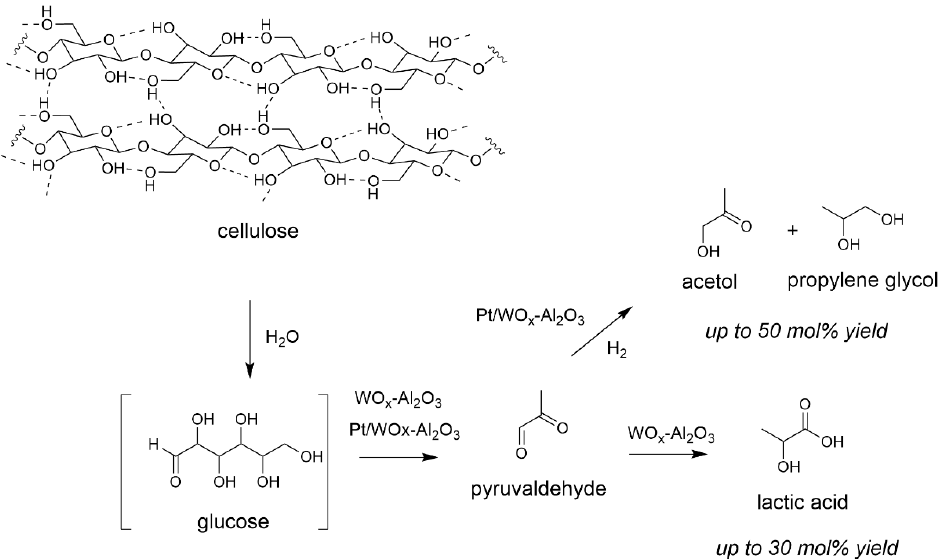
Scheme 3. Reaction pathways of cellulose transformation in the presence of solid Lewis acids (water 65 mL, Avicel